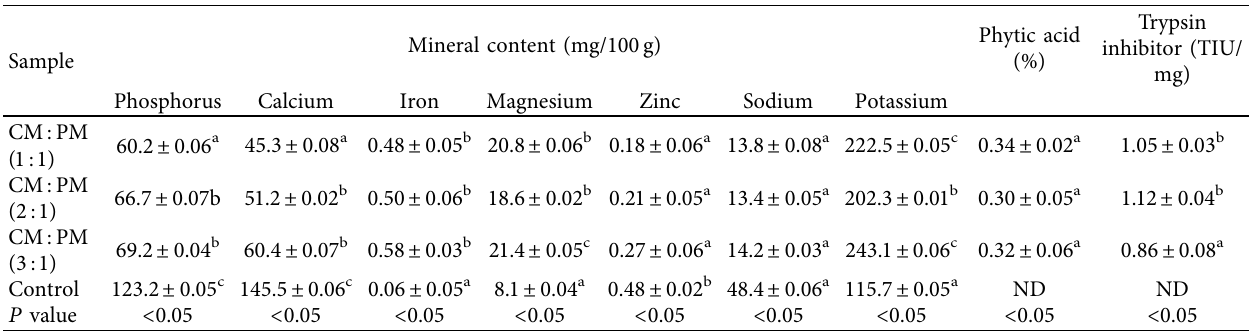
Table 3: Mineral and antinutritional composition of fermented cowpea-peanut milk with L. rhamnosus Yoba.